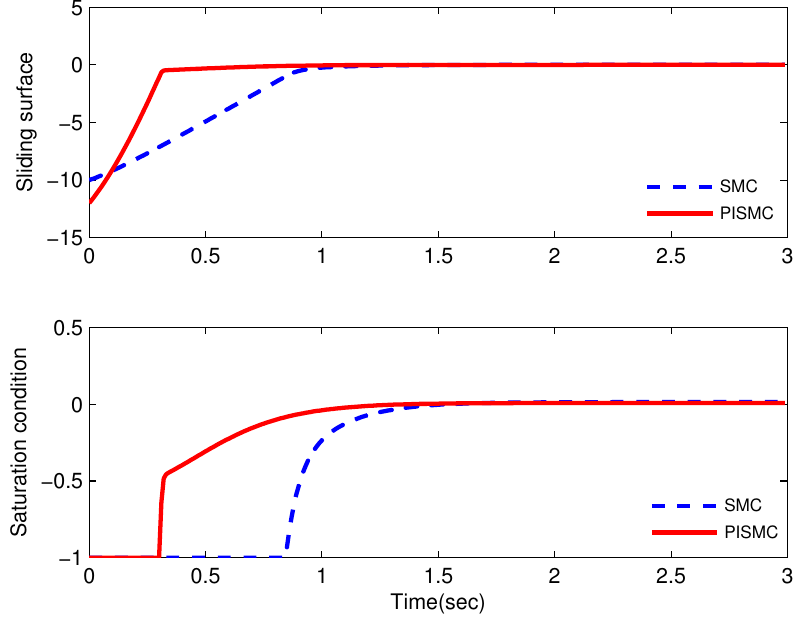
Figure 11. Switching and sliding signal for PISMC without disturbances: ( top ) history of sliding surface values; ( bottom ) history of saturation conditions.